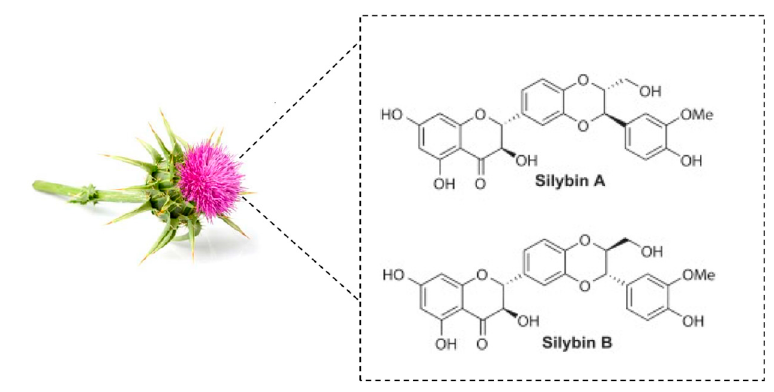
Figure 1. Major compounds of silymarin from Milk Thistle.